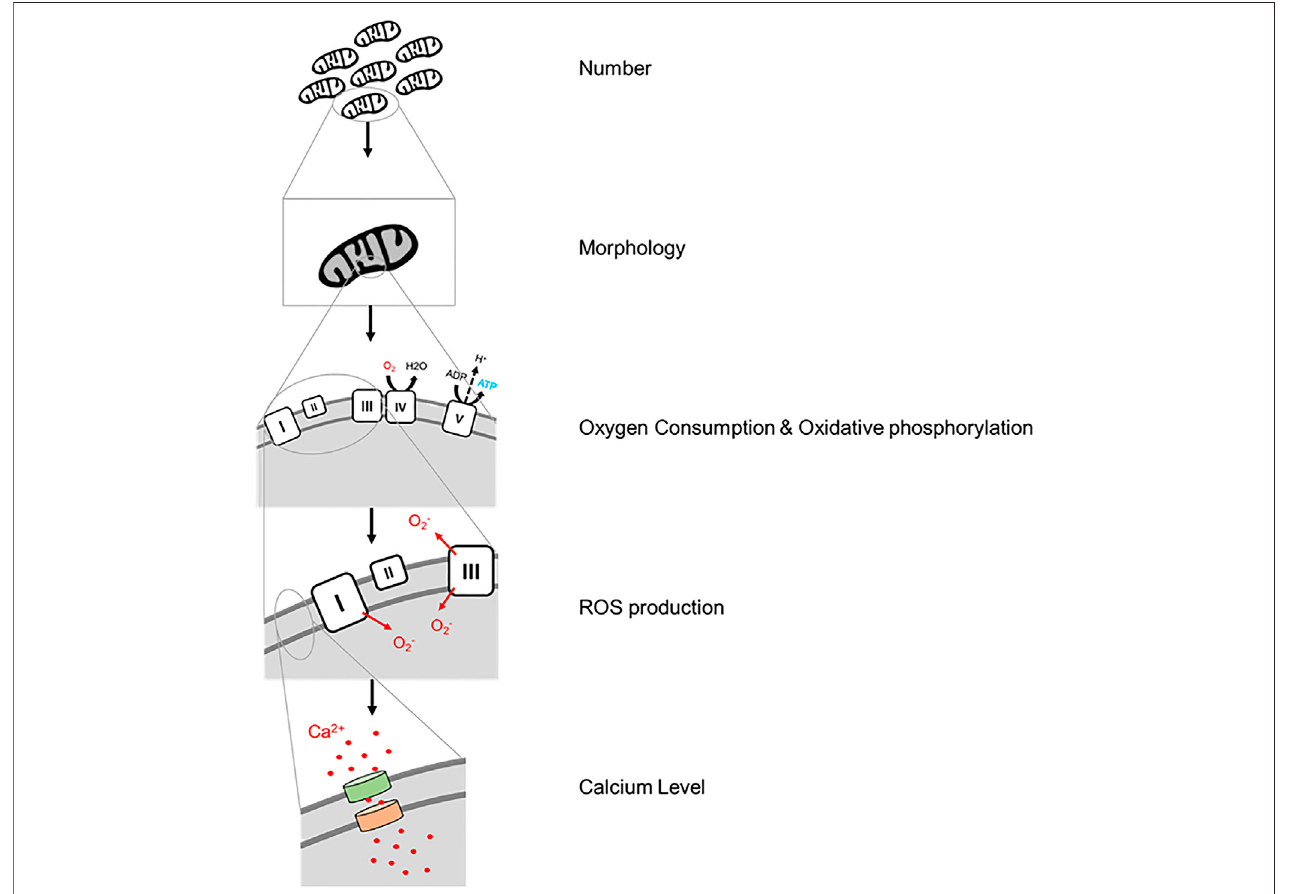
FIGURE 2 | Graphical representation of the levels of mitochondrial testing that are possible